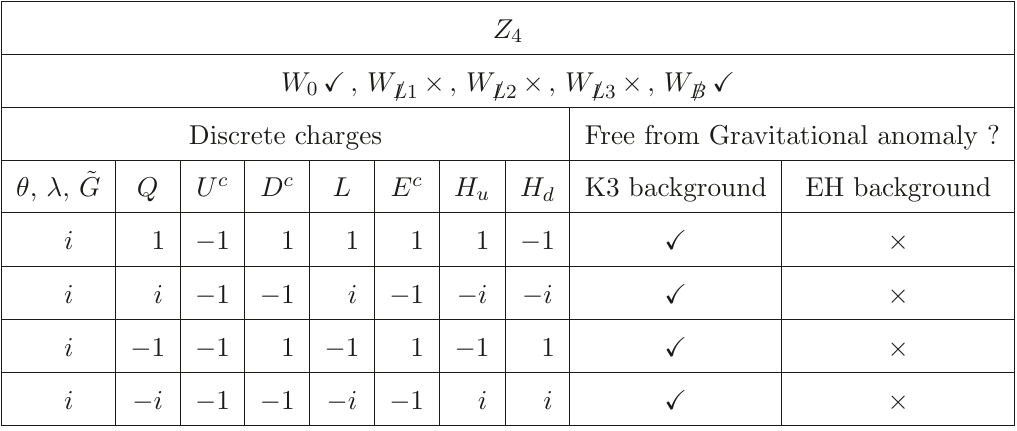
Table 7 . See the caption of table 2 for notations, and refer to the main text for more